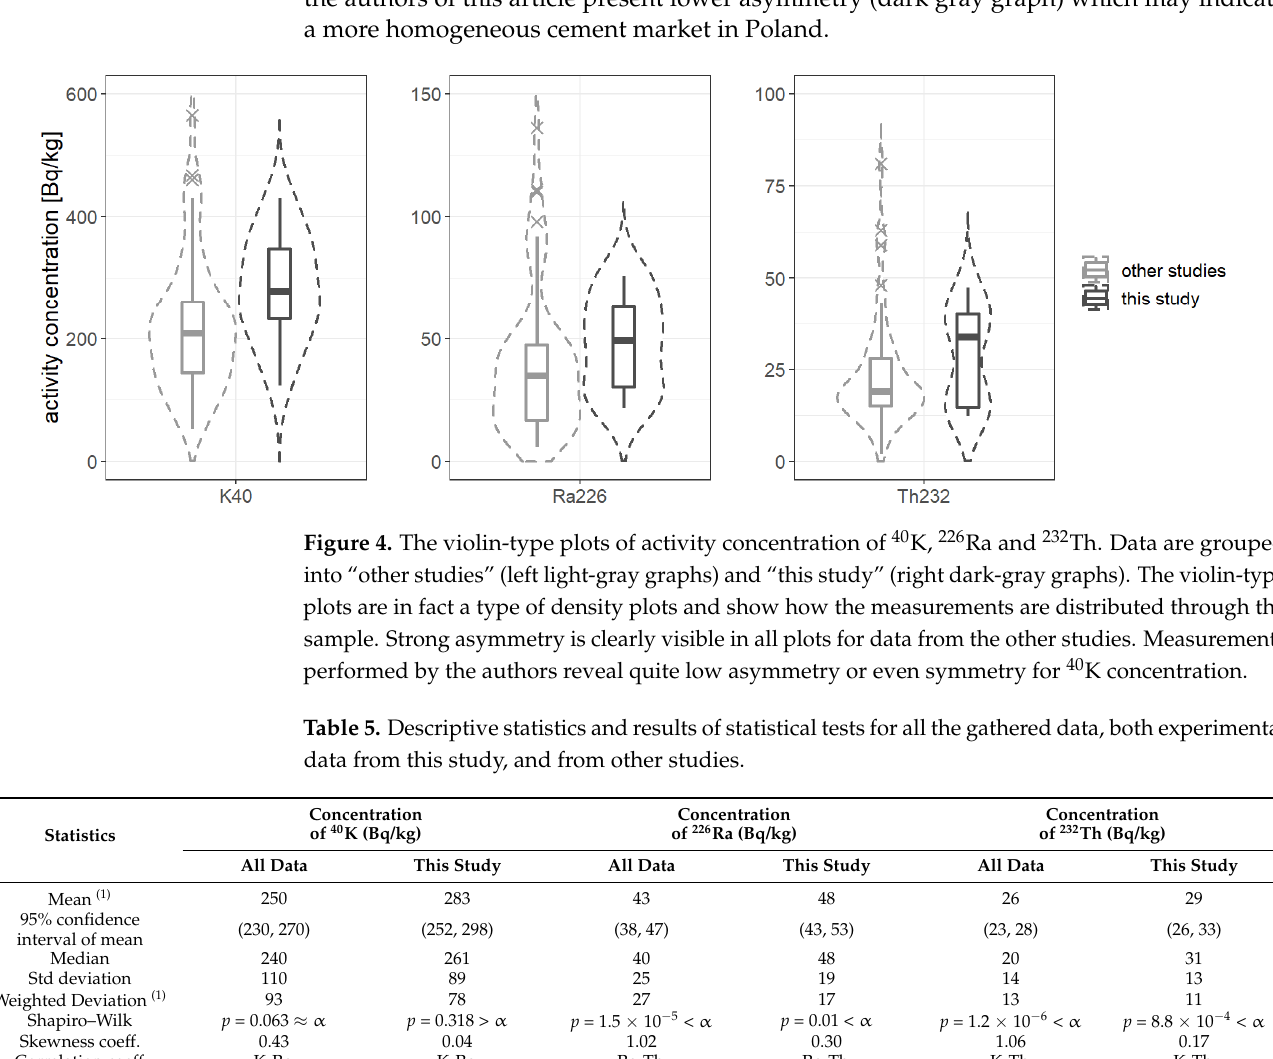
Figure 3. Box-whisker plots for the concentration of potassium ( a ), radium ( b ), and thorium ( c ). Box- plots present the basic values of descriptive statistics: the median (horizontal line), the first and the third quantile (bottom and top side of the box, respectively), the maximum and minimum values not considered an outlier (upper and lower whisker border, respectively), and outliers and extreme values. The figure contains separate boxes for different cement types as to extract statistical differences between these groups, if exist. All the collected data, both from other studies and the measurements of the authors of this study, were used to prepare the above charts.